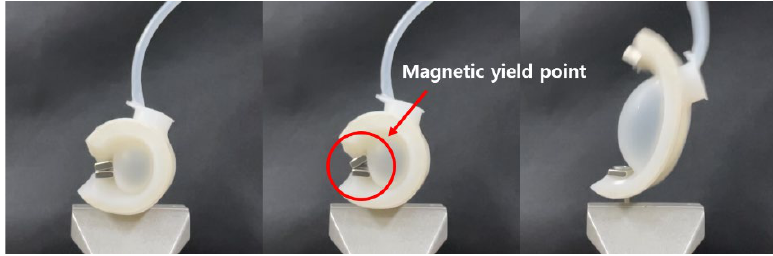
Figure 12. Movement of soft jumping mechanism at the magnetic yield point.